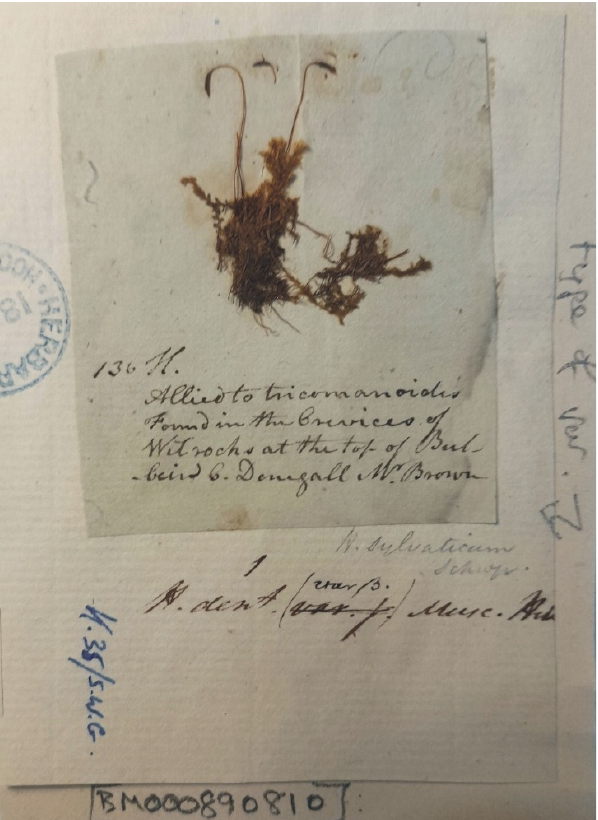
Figure 4. Specimen of H . denticulatum var. obtusifolium (BM000890810), photo by G.J. Wolski, Ł ód ź , March 2022.